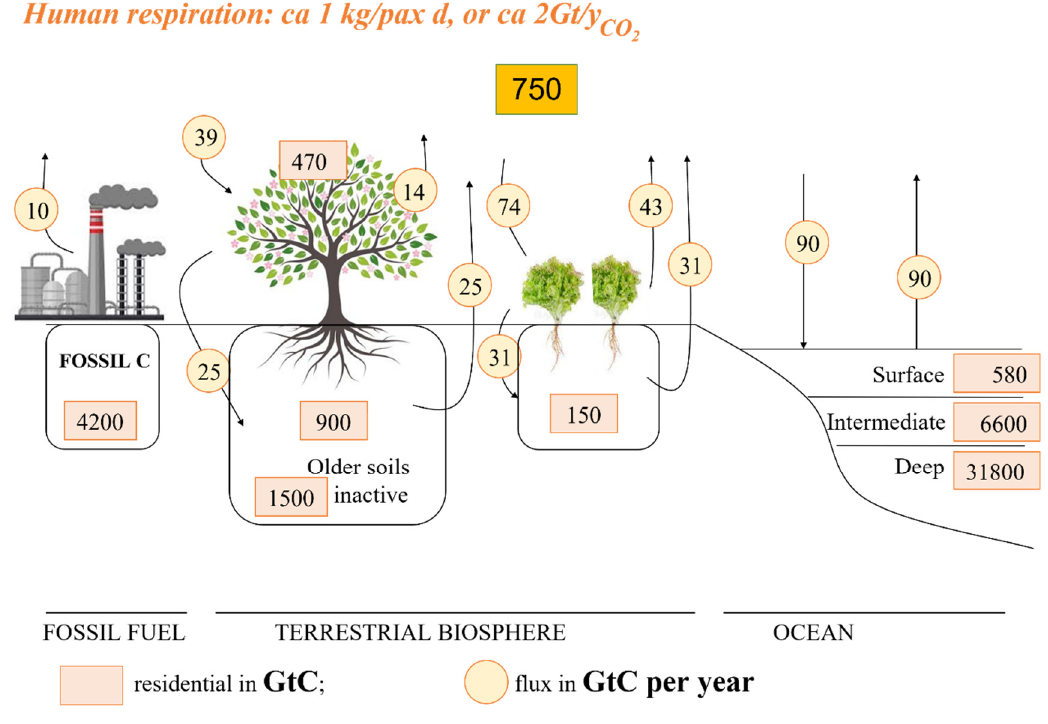
Figure 1. The natural C